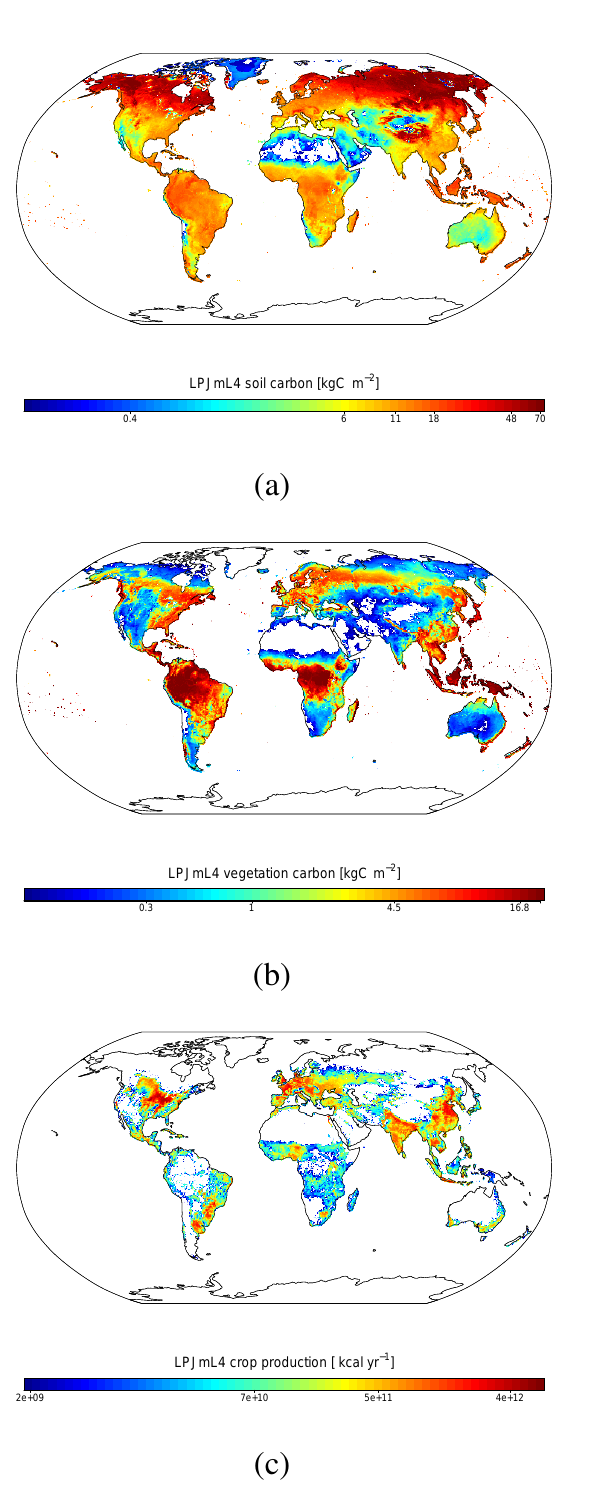
Figure 4. Annual GPP (a) , NPP (b) , and fire carbon emissions (c) computed by LPJmL4 as an average of the time period 1996–2005. Note: values for fire carbon emissions are plotted on a logarithmic